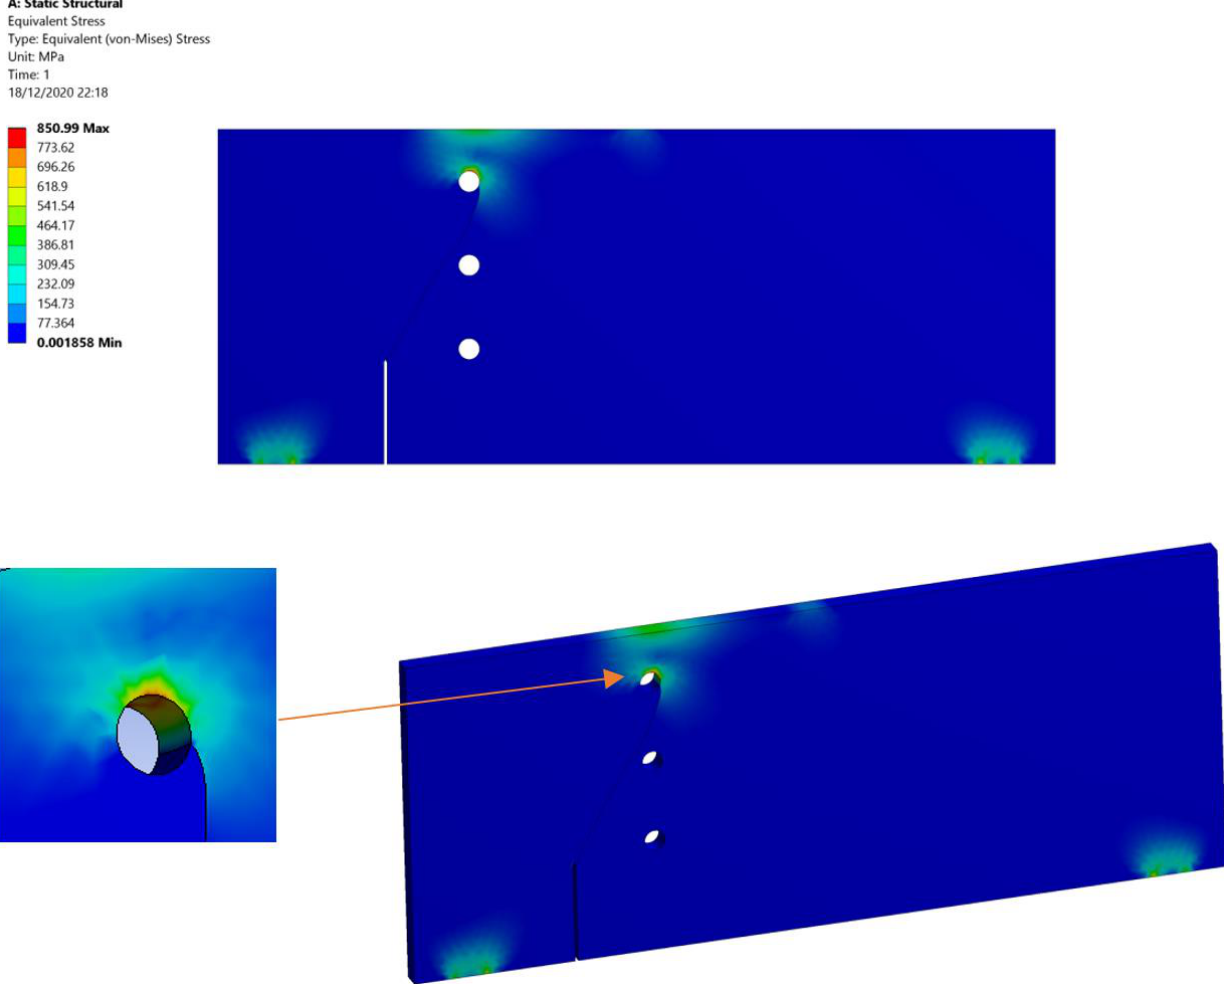
Figure 17. Equivalent Von-Mises stress distribution for specimen 5.